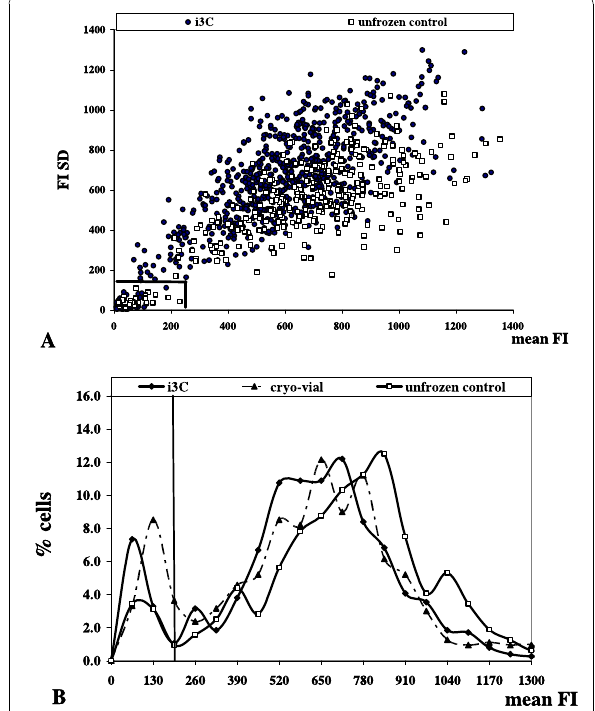
Figure 4 Characteristics of the mitochondria in U937 cells after the freezing - thawing cycle (1.5 hours) . (A). Scattered diagram of single cells ’ mean FI (X axis) vs. FI SD (Y axis) for individual cells stained with TMRM in the i3C (1.5 hours after the freezing - thawing cycle) and unfrozen control. Each dot represents an individual cell. (B) Distribution histograms of FI values in individual U937 cells that underwent the freezing - thawing cycle in the i3C, standard cryo- vials and the unfrozen